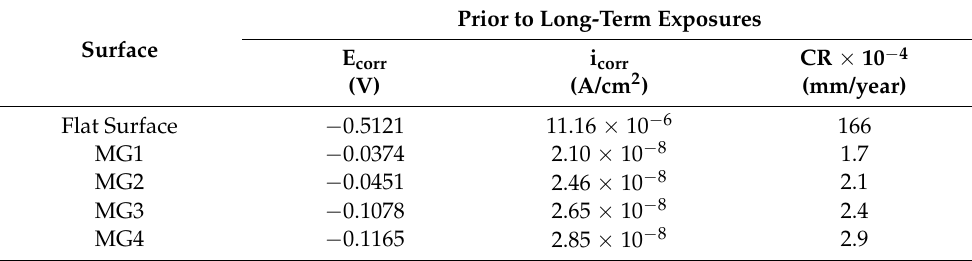
Table 3. Corrosion potential (E corr ), corrosion current density (i corr ) and corrosion rate (CR) of surfaces, prior to long-term exposures to 3.5 wt. % NaCl